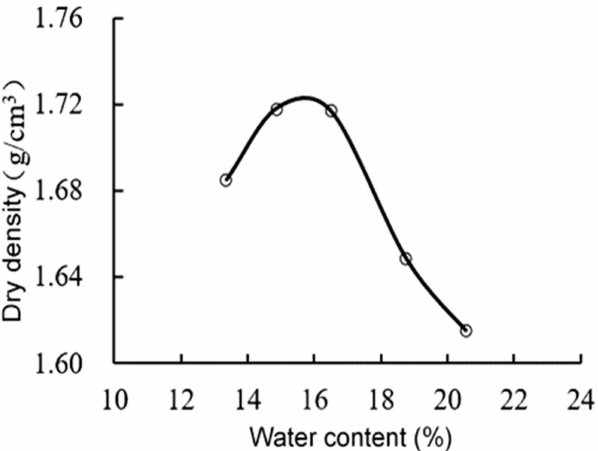
Figure 3. Compaction curve for the Yan’an